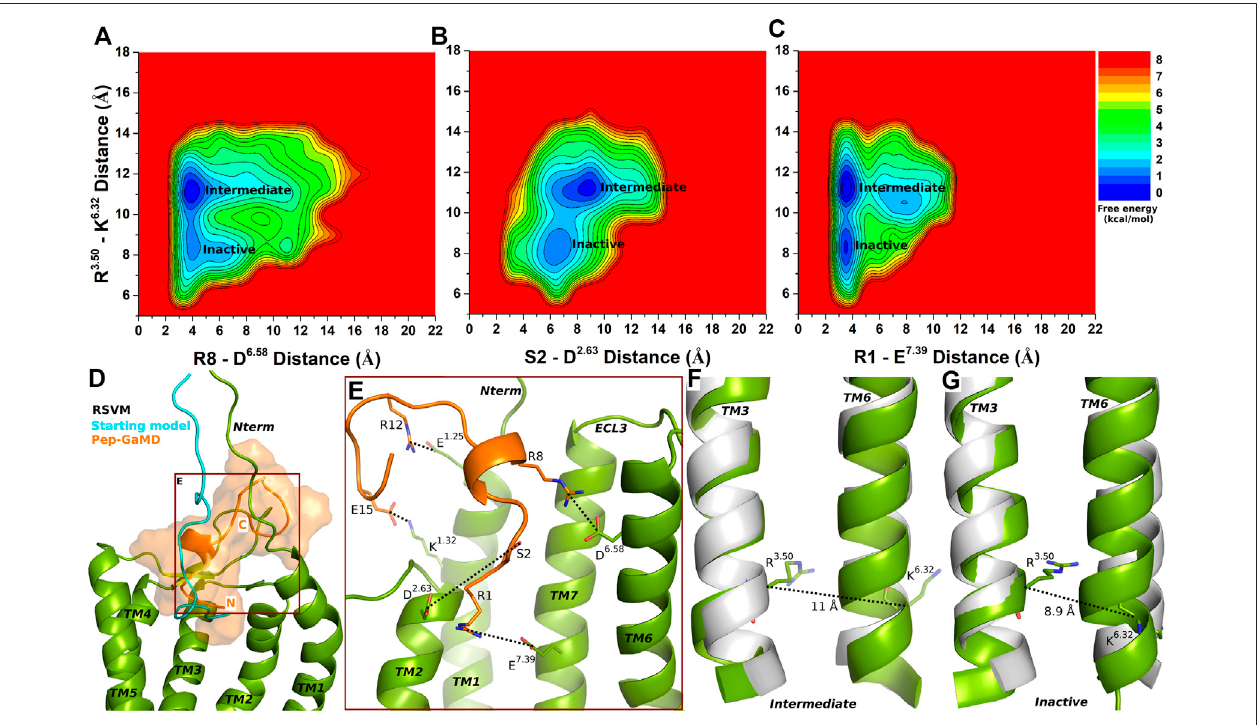
FIGURE 4 | Partial agonist RSVM bound CXCR4 sampled Intermediate and Inactive low-energy states. (A – C) Free energy pro fi les of CXCR4-RSVM interactions calculated regarding the distance between the C α atoms of R 3.50 and K 6.32 and (A) distance between charge centers of peptide residue R8 (the CZ atom) and receptor residue D 6.58 (the CG atom), (B) distance between charge centers of peptide residue S2 (the OG atom) and receptor residue D 2.63 (the CG atom), (C) distance between charge centers of peptide residue R1 (the CZ atom) and receptor residue E 7.39 (the CD atom). (D) Comparison of the top-ranked structural cluster of the partial agonist RSVM obtained from Pep-GaMD simulations (orange cartoon) with the starting computational model (cyancartoon). (E) Important residue interactionsbetween thepeptide(orangesticks)andreceptor(greensticks)observedinthePep-GaMDsimulations. (F – G) TheTM3-TM6distancebetweentheC α atomsofR 3.50 andK 6.32 as observed in the (F) Intermediate and the (G) Inactive